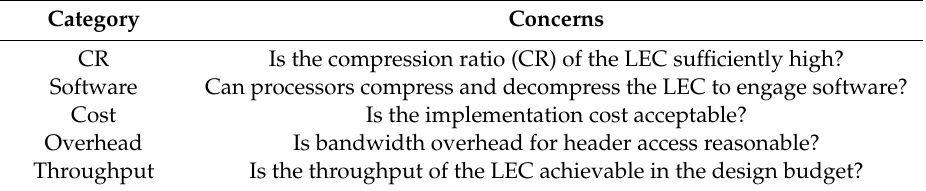
Table 1. Concerns to consider when developing lossless embedded compression (LEC).